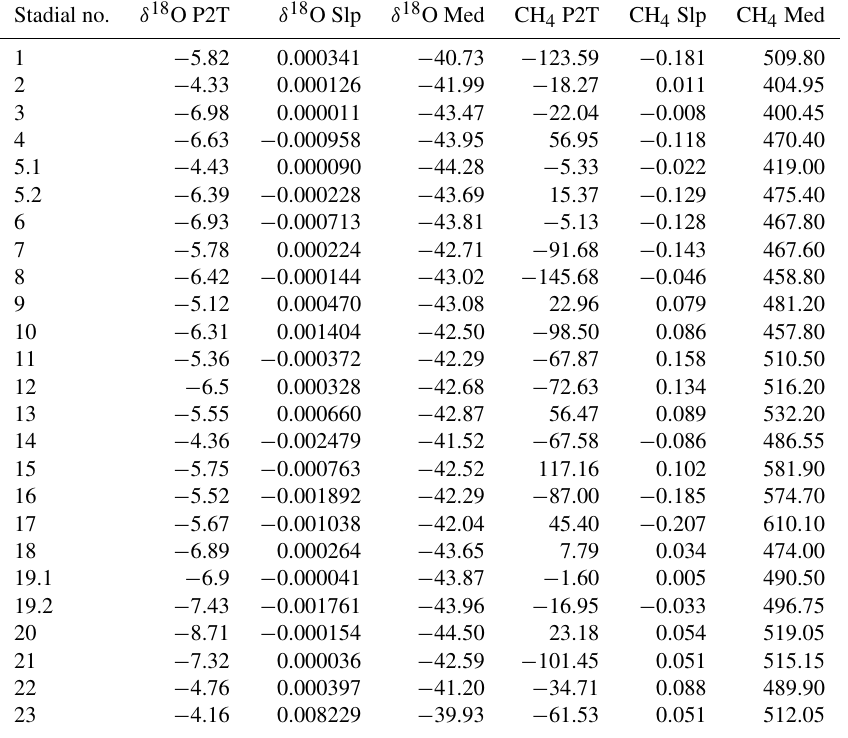
Table 2. Metric measurements for Greenland records by stadial number. Abbreviations for records are given by δ 18 O: NGRIP δ 18 O and CH 4 : NGRIP CH 4 , and abbreviations for metrics are given by P2T: peak-to-trough, Slp: stadial slope, and Med: